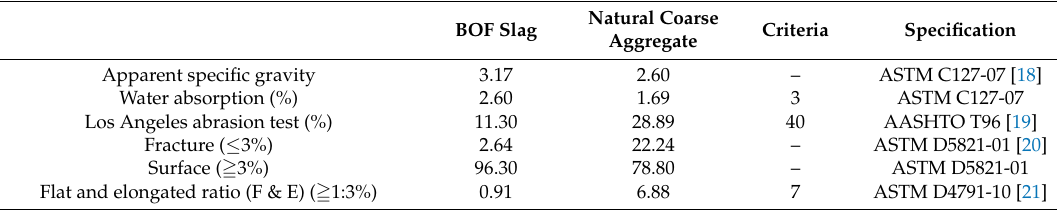
Table 1. The basic oxygen furnace slag (BOF) slag and natural aggregate properties.